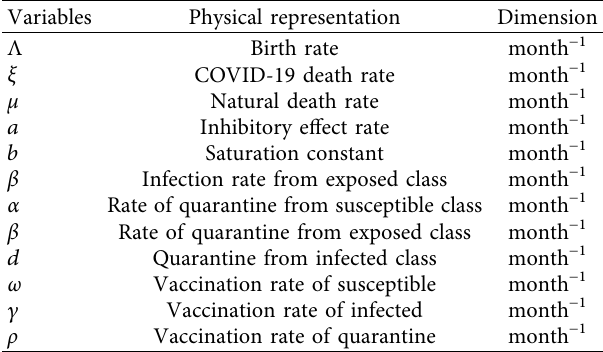
Table 2: Te parameters and their description involved in model